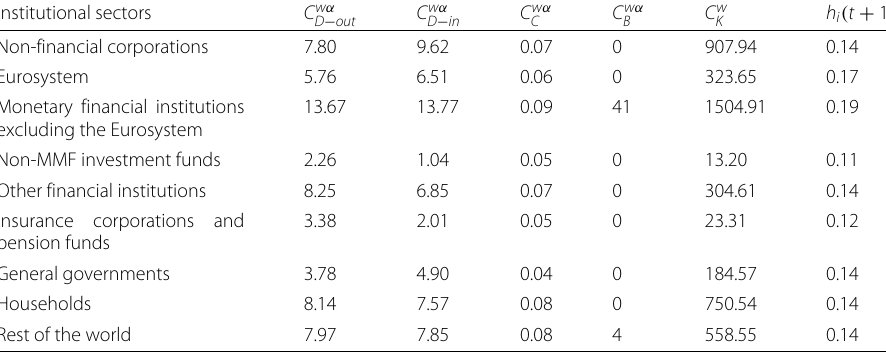
Table 1 Network statistics - loan and deposit